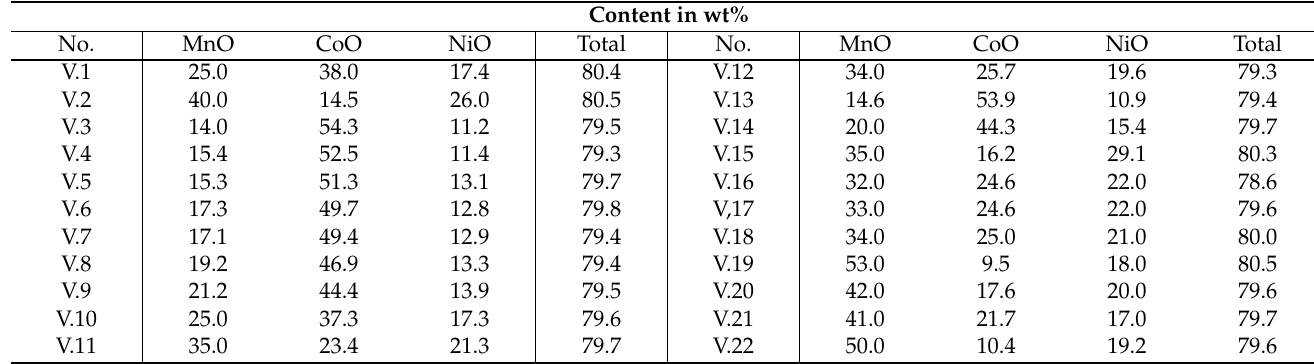
Table 1. Representative SEM–EDS analyses of (Co–Mn–Ni)-hydroxides from metamorphosed Fe–Ni laterites from E. Vermion.